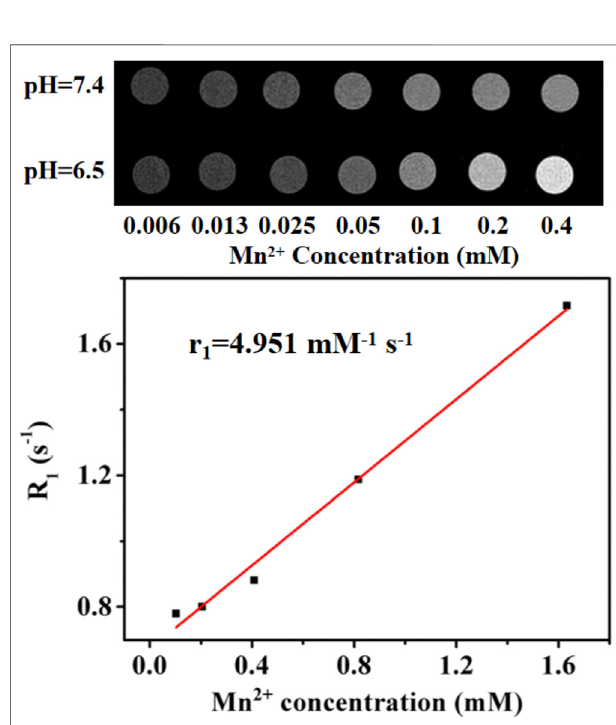
FIGURE 6 | MRI images of MONs@PDA with increased Mn 2+ content (0.006, 0.013, 0.025, 0.05, 0.1, 0.2, 0.4 mM) at different pH and T 1 relaxation